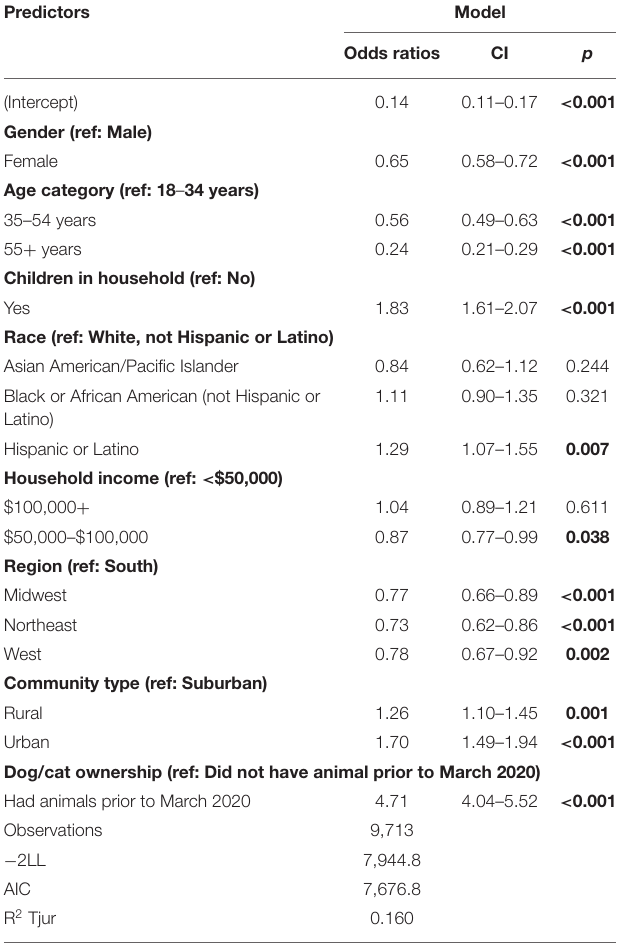
TABLE 4 | Results of binary logistic regression model assessing factors associated with having acquired a dog and/or cat during the pandemic. Dog Cat N (%) N (%)